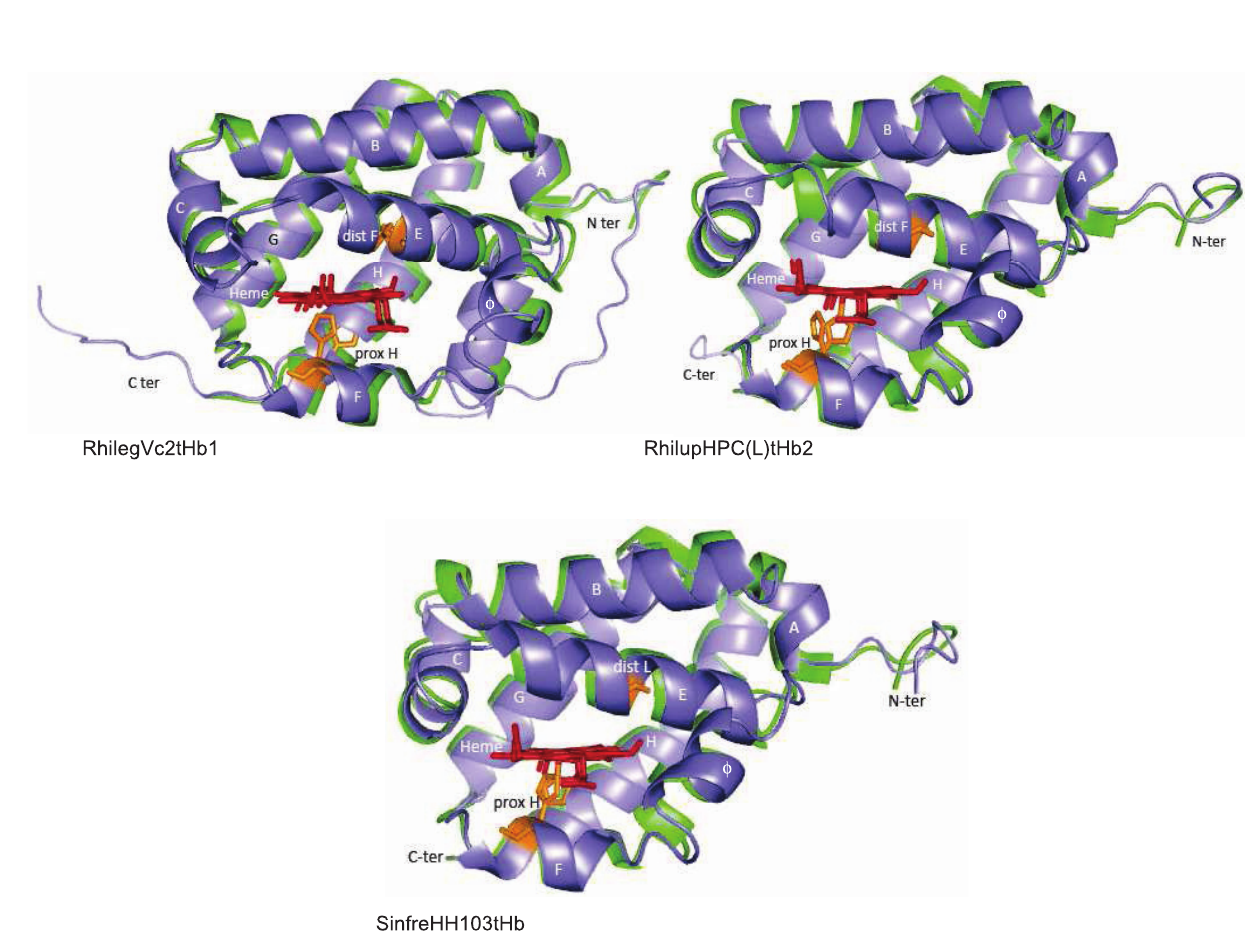
Figure 7. Predicted structure of selected rhizobial tHbs class 2 (blue) overlapped to structural homologues (green). Structural homologues are indicated in Dataset 3. Distal and proximal amino acids to the heme Fe are shown in brown; only potential distal E11 is shown in the tHbs structure. Heme is shown in red. Helices are indicated with letters A to H. Pre-helix F is indicated with the Greek letter φ . All structures are displayed in the same orientation.